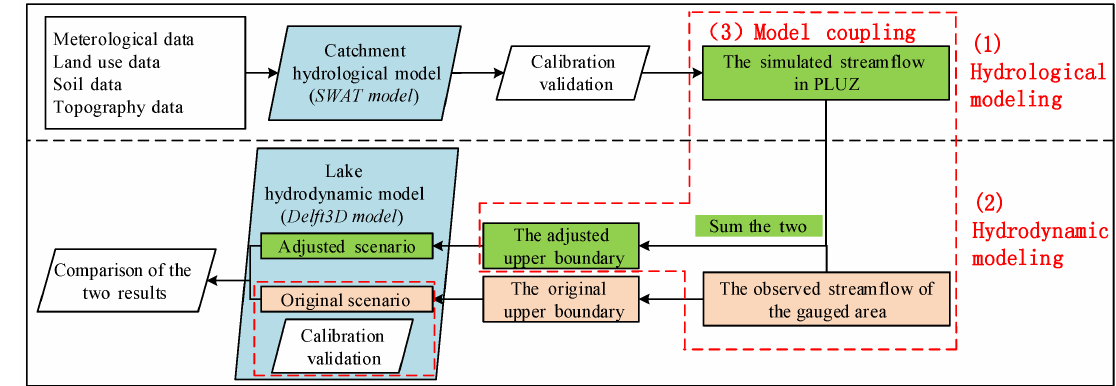
Figure 2. Conceptual flow chart for stream flow simulation and verification in ungauged zones by coupling hydrological and hydrodynamic models. The flow chart includes three parts: hydrological modeling, hydrodynamic modeling, and model